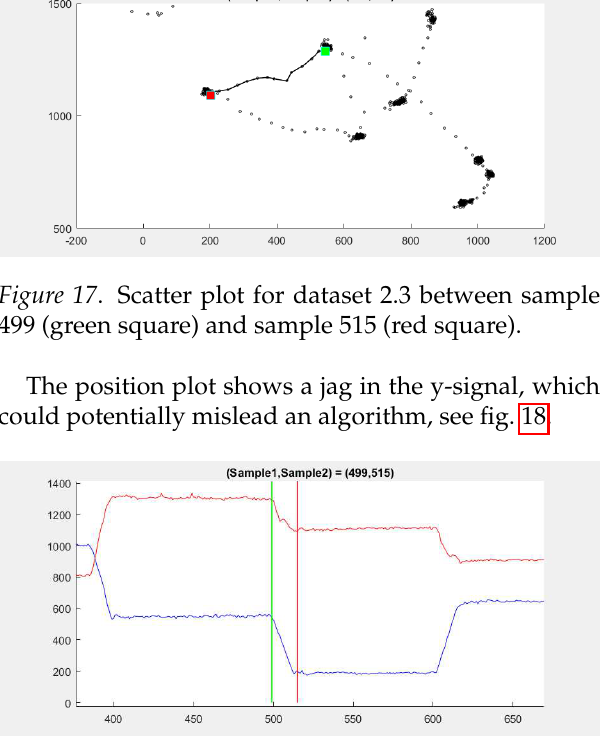
Figure 18 . Position plot for dataset 2.3 between sample 499 (green line) and sample 515 (red line). A jag occurs at sample 504, potentially misleading